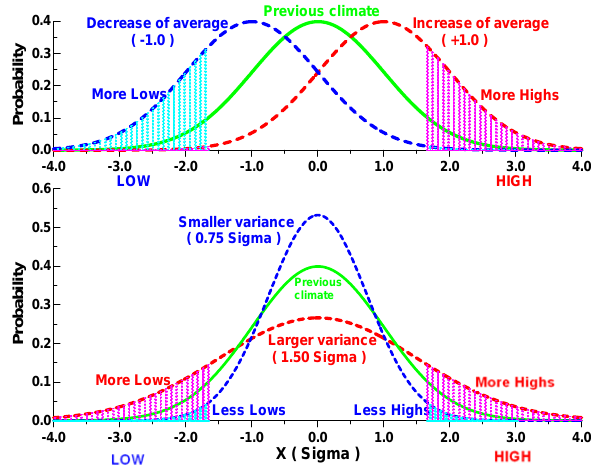
Fig. 2. Illustration of two contents in climate